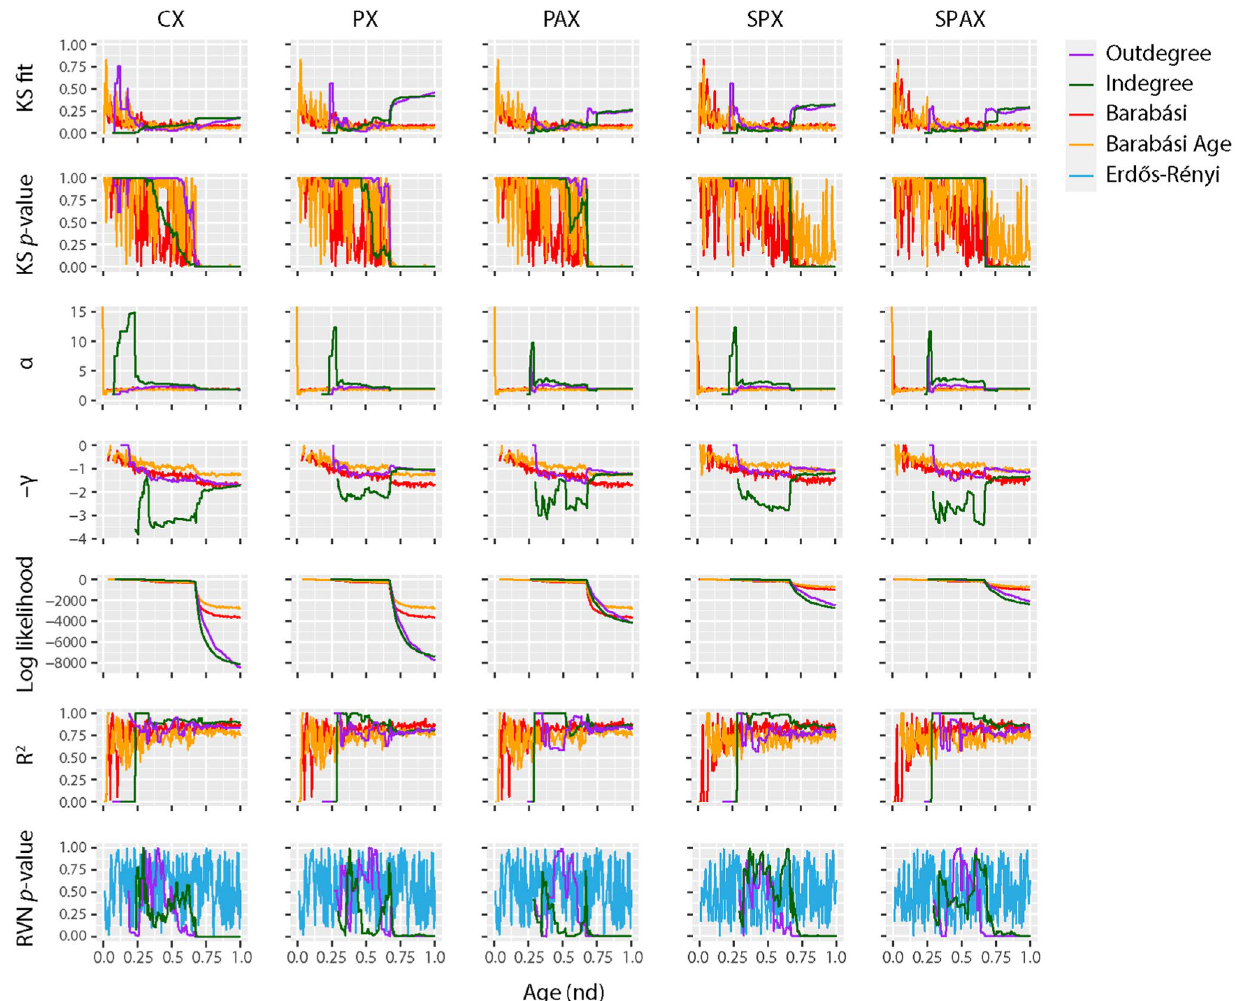
Figure 4. Statistical descriptors of power law and random behavior. Six indicators of preferential attachment were studied along the evolutionary timeline to explore processes of network growth, with network age ( nd ) indicated on a relative 0-to-1 scale. Outdegree and indegree connections were cumulative and weighted in evolving networks. Barabási (red) and Barabási-Age (orange) networks were included as control sets. The Barabási model specifies the probability of preference of an old node as P i ~ k i α while the Barabási-Age model grants heavier power law properties to older nodes (exhibiting smaller nd ) with P i ~ (k i α )(l i β ), where k i is the indegree of node i of the current event, α is the preferential attachment exponent (α = 1 for linear preferential attachment), l i is the age of node i, i.e. the number of events elapsed since the node was added, with maximum number measured by the ‘aging.bin’ parameter, and β is the aging exponent (β = 1 for linear increases in probability of preference of an older node with high l i ). Power law indices include: (1) the KS fit statistic that compares the input degree data distribution with the fitted power law distribution (smaller scores denote better fit); (2) the KS p value, which rejects the null hypothesis that degree data was drawn from the fitted power-law distribution when less than α = 0.05; (3) the exponent of the fitted power-law distribution (α); (4) the slope of power-law linear regression model (γ); (5) the log-likelihood of the fitted parameters; and (6) the coefficient of determination (R 2 ) that measures the percentage of degree data that fits the linear model. The randomness of the evolving networks was quantified by the p value of an approximated beta distribution from the rank version of von Neumann’s Ratio Test for Randomness 89 (RVN p value ). The alternate hypothesis was non-randomness. Comparative graphs of strictly random Erdős–Rényi control networks of corresponding sizes at the given time- events were also plotted. Lower KS fit, higher KS p value, higher α, lower −γ and near-zero likelihood, given lower RVN p value , support power law